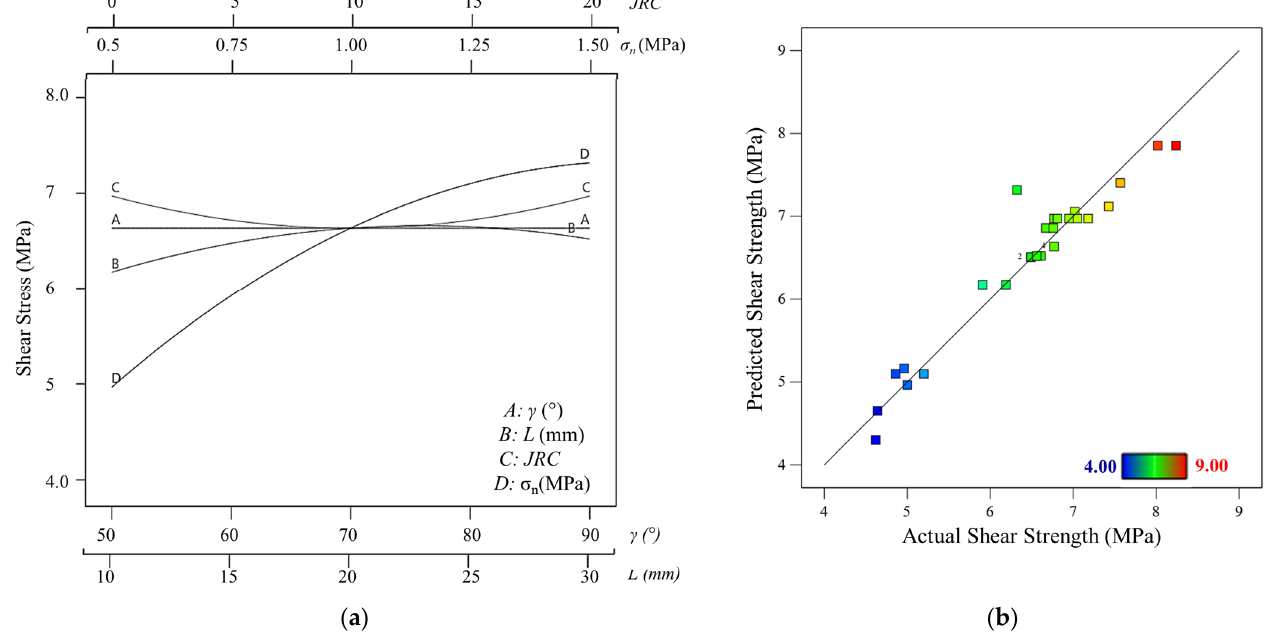
Figure 12. ( a ) Effect of noncoplanar joint parameters on the shear strength of specimens with the same joint length (2a = 10 mm). ( b ) Predicted vs. actual shear strength scatterplot of RSM results (Equation